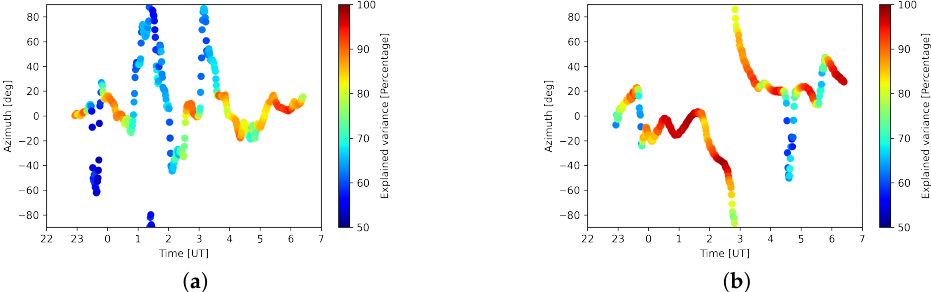
Figure 18. L79324 PCA azimuths for principal components ( a ) at 3 min central period and ( b ) at 12 min central period. Color scale shows percentage of signal’s variance explained by the